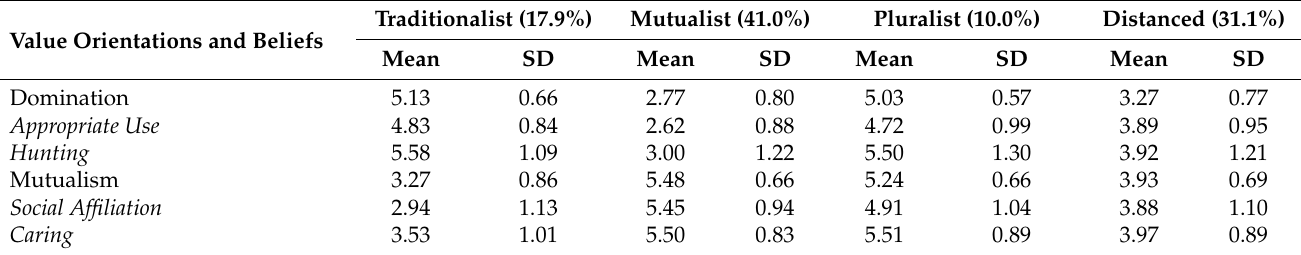
Table 3. Wildlife value orientation type scores a by basic orientations and beliefs of the sampled Greek population ( n = 2392). Value Orientations and